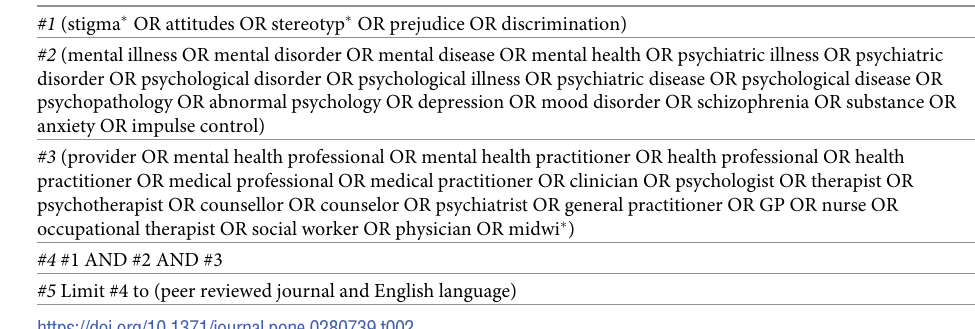
Table 2. Search query protocol and flow for